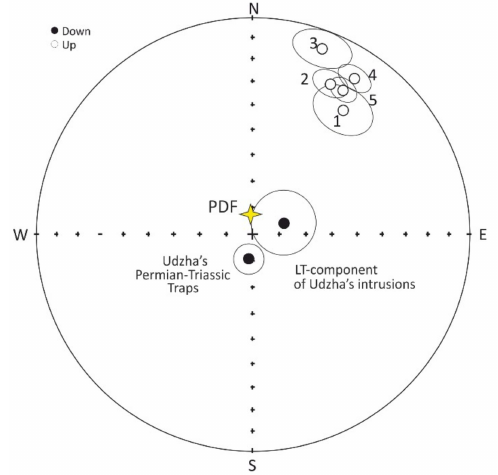
Figure 5. Equal-area stereographic projection of all site means reported in this study. 1—the Great Udzha Dyke; 2—sill at the Udzha and Hapchanyr river junction; 3—dyke; 4—dykes of the Kotuy-Olenek complex [14]; 5—sill at the Udzha and Hapchanyr river junction [14]. PDF—present day magnetic field in the study area.